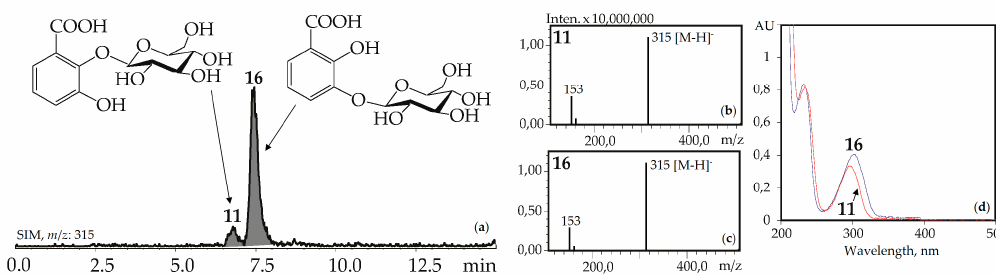
Figure 4. ( a ) HPLC-ESI-MS chromatogram of G. gelida herb extract in SIM-mode ( m / z 315). ( b , c ) Mass spectra (negative ionization) of compounds 11 (2,3-dihydroxybenzoic acid 2- O -glucoside) and 16 (2,3-dihydroxybenzoic acid 3- O -glucoside), respectively. ( d ) UV spectra of compounds 11 and 16